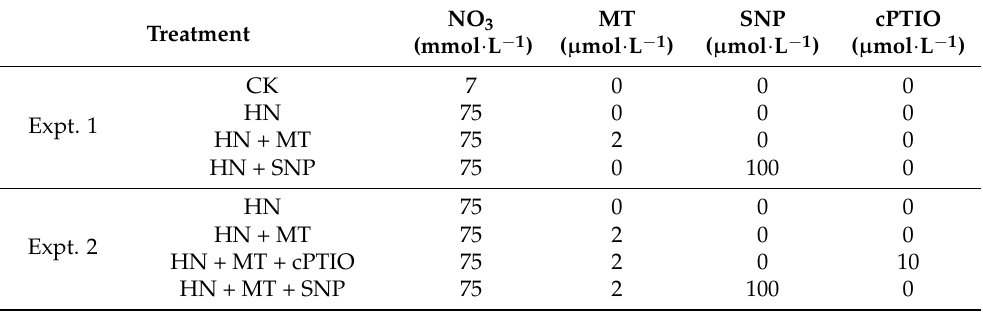
Table 2. Nutrient solution treatments in two